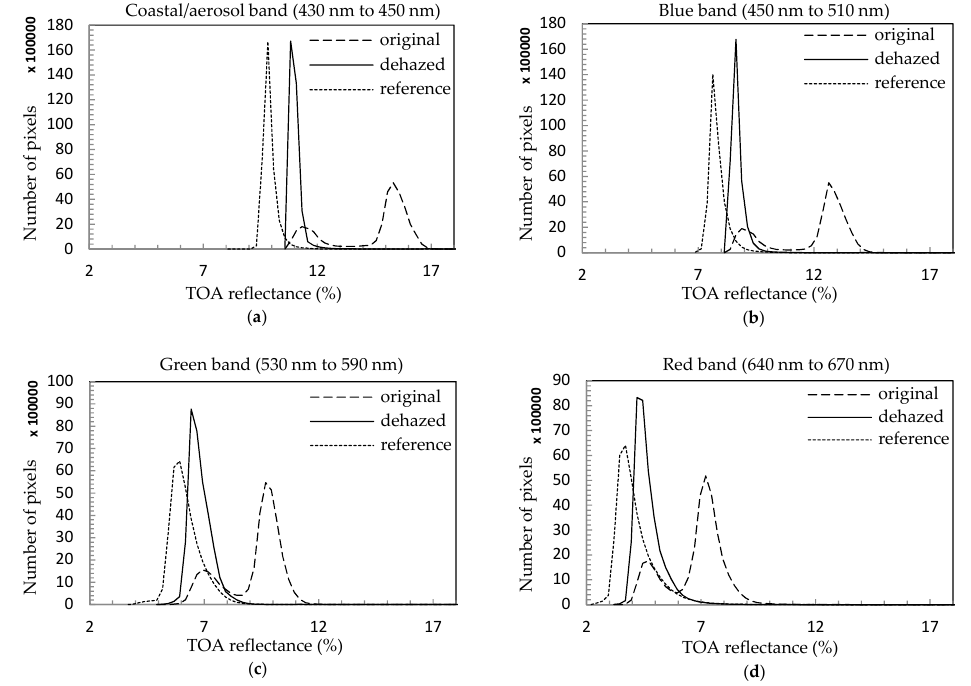
Figure 8. Histograms taken from the hazy (long-dashed curves, scene ID: LC80290242014212LGN00), dehazed (solid curves) and reference (short-dashed curves, scene ID: LC80290242014228LGN00) images of four visible bands: ( a ) coastal/aerosol band (430 nm to 450 nm); ( b ) blue band (450 nm to 510 nm); ( c ) green band (530 nm to 590 nm); and ( d ) red band (640 nm to 670 nm).